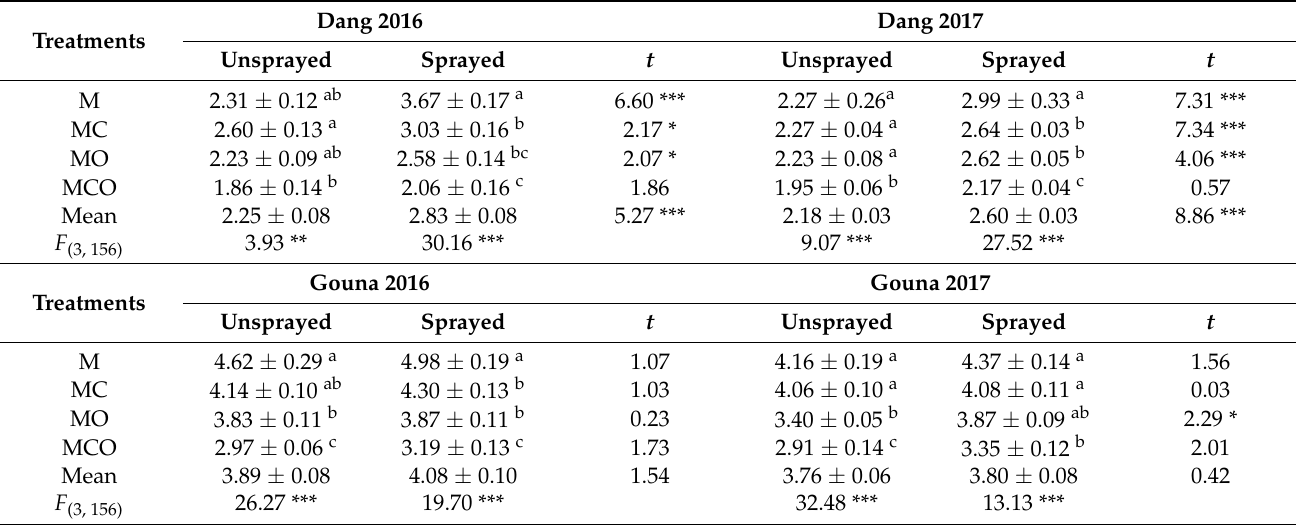
Table 3. Maize yield (t ha − 1 ) as influenced by Cypermethrin treatments and intercropping system in 2016 and 2017 at Dang and